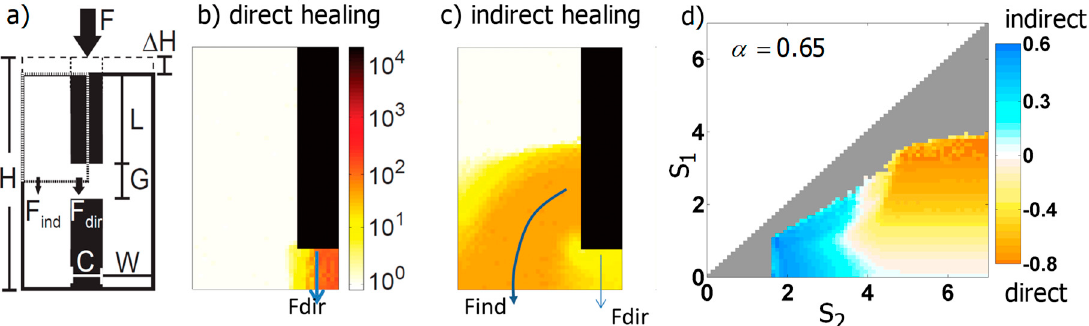
Figure 5. ( a ) 2D geometry of the model, where the black rectangles correspond to the disconnected stiff material surrounded by a soft, mechanoresponsive material (white). Loading of the broken material by a force F results in a vertical deformation Δ H . Due to symmetry, only a quarter of the system shown had to be modeled (marked by the dashed line). ( b , c ) Snapshots of two different simulations, which demonstrate that healing can progress either directly via a bridging of the fracture gap or indirectly, by reconnecting the broken ends circumferentially. ( d ) Parameter study varying the upper and lower bound of the range of mechanoresponsiveness, s 2 , and s 1 , respectively [63]. The colors denote whether the course of healing was more direct or indirect. Grey pixels indicate an unsuccessful healing defined by a failed reduction of Δ H below 1%.